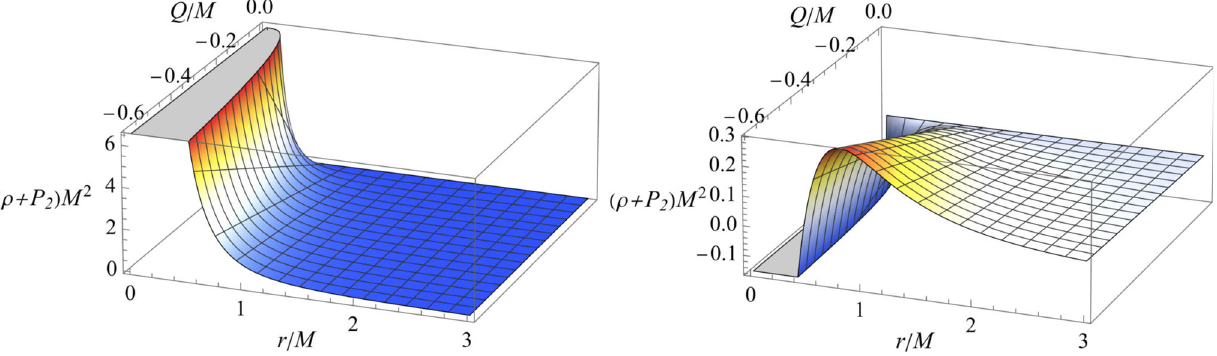
Fig. 4 Plots of ρ + P 2 vs radius r and hair Q for a = 0 (left) and a = 0 . 8 M